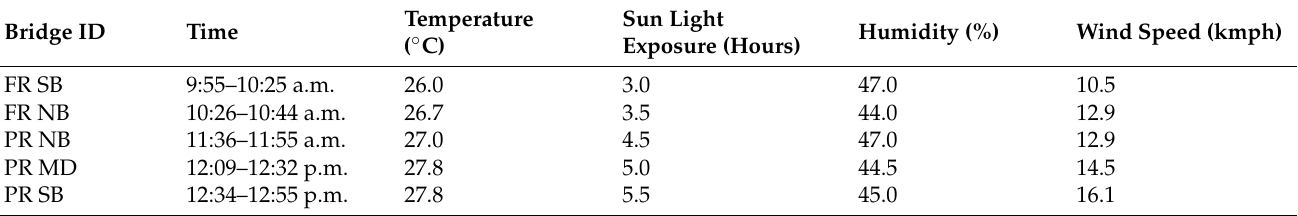
Table 4. UAS and IR camera specifications.